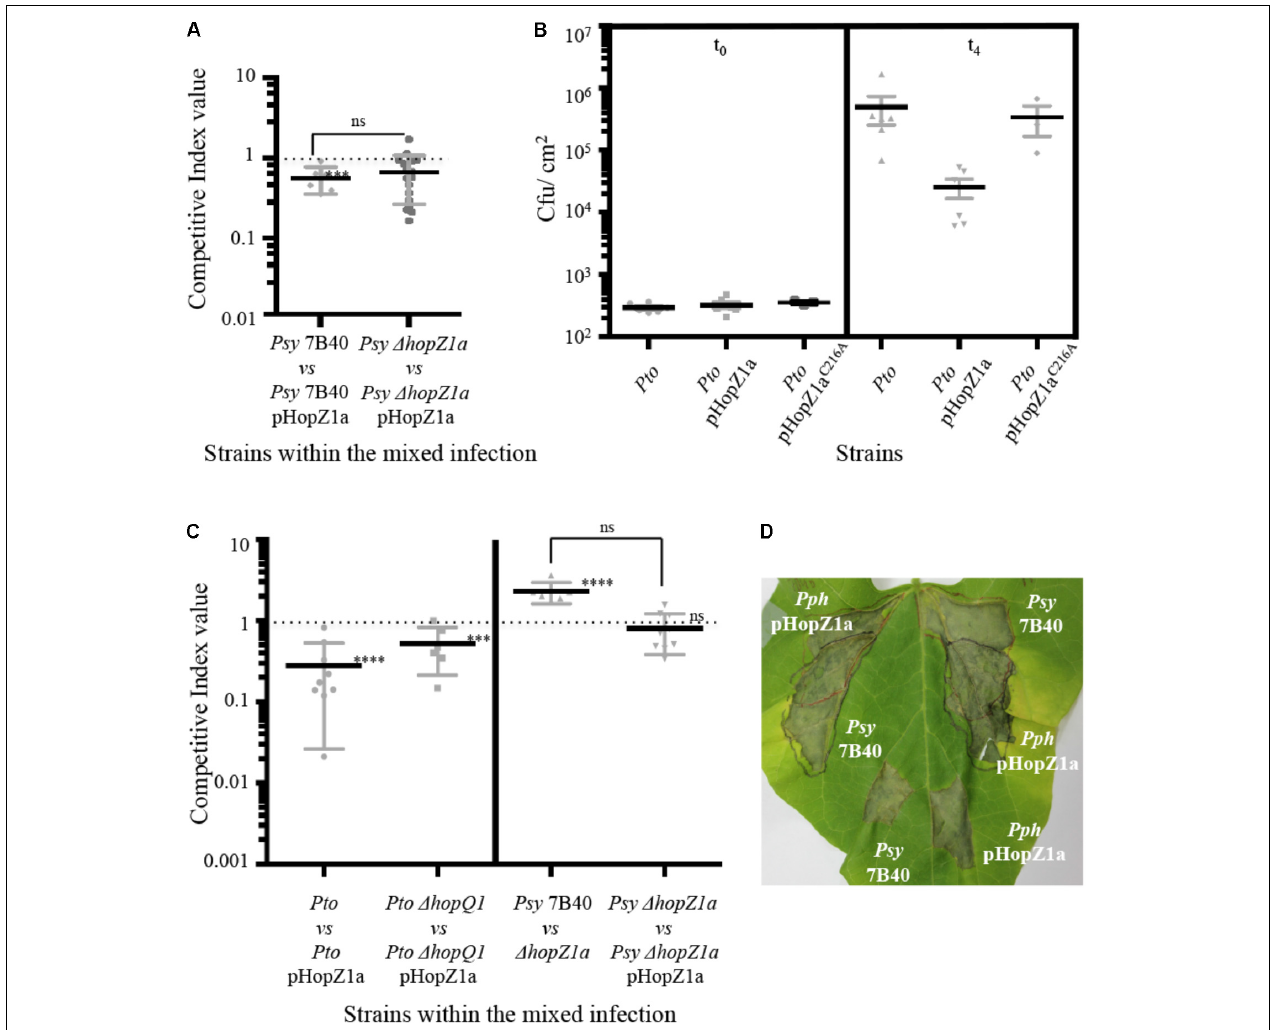
FIGURE 2 | HopZ1a-triggered immunity in bean is suppressed when delivered by Psy 7B40. (A) Competitive indices (CIs) measuring bacterial proliferation in bean of Psy 7B40 or Psy 7B40 (cid:49) hopZ1a- carrying pHopZ1a (pAME30), related to proliferation of Psy 7B40 or Psy 7B40 (cid:49) hopZ1a , respectively. CIs are calculated as the output ratio between the strain expressing the effector and the corresponding wild type or mutant strain, divided by their input ratio. Leaves were infiltrated with a (1:1) 5 × 10 4 cfu/ml bacterial suspension. Each CI mean represents the means of at least three independent experiments with three biological replicates each. Individual values are shown for each CI. Error bars represent the standard error. Mean values marked with asterisk(s) were found significantly different from 1.00 or from each other as established by Student’s t -test ( ∗∗∗ P < 0.005; ns not significant). (B) Bacterial proliferation within bean leaves. Bean leaves were inoculated by infiltration with bacterial suspensions containing 5 × 10 4 cfu/ml of Pto DC3000, Pto DC3000-carrying pHopZa1 (pAME30) or Pto DC3000-carrying pHopZ1a C216A (pAME27). Bacterial loads were determined immediately after inoculation or 4 days post-inoculation (dpi). Individual values are shown. Error bars represent standard error. Smallest error bars may be covered by the mean and or individual symbols. (C) CIs measuring bacterial proliferation in N. benthamiana of Pto DC3000, Pto DC3000 (cid:49) hopQ1 , or Psy 7B40 (cid:49) hopZ1a -carrying pHopZ1a (pAME30), related to proliferation of the corresponding strain without the plasmid, and Psy 7B40 (cid:49) hopZ1a in relation to that of Psy 7B40. CIs are calculated as the output ratio between the strain expressing the effector and the corresponding wild type or mutant strain, divided by their input ratio. Leaves were infiltrated with a 5 × 10 5 cfu/ml bacterial suspension (2.5 × 10 5 cfu/ml of each strain, a 1:1 ratio). Each CI mean represents the means of at least three independent experiments with three biological replicates each. Individual values are shown for each CI. Error bars represent the standard error. Mean values marked with asterisk(s) were found significantly different from 1.00 or from each other as established by Student’s t -test ( ∗∗∗ P < 0.005; ∗∗∗∗ P < 0.001; ns not significant). (D) Bean leaves infiltrated with 10 7 cfu/ml of Psy 7B40 or Pph 1448A-carrying pHopZ1a (pAME30) either separately (bottom) or covering overlapping areas (top). In the later case, one infiltration was carried out first followed by the second infiltration 2 h later. Pph 1448A-carrying pHopZ1a (pAME30) was infiltrated first (top left) or second (top right) to rule out differences due to inoculation order. Photographs were taken 8 dpi. Each experiment included at least three replicates. Experiments were repeated at least twice with similar results.